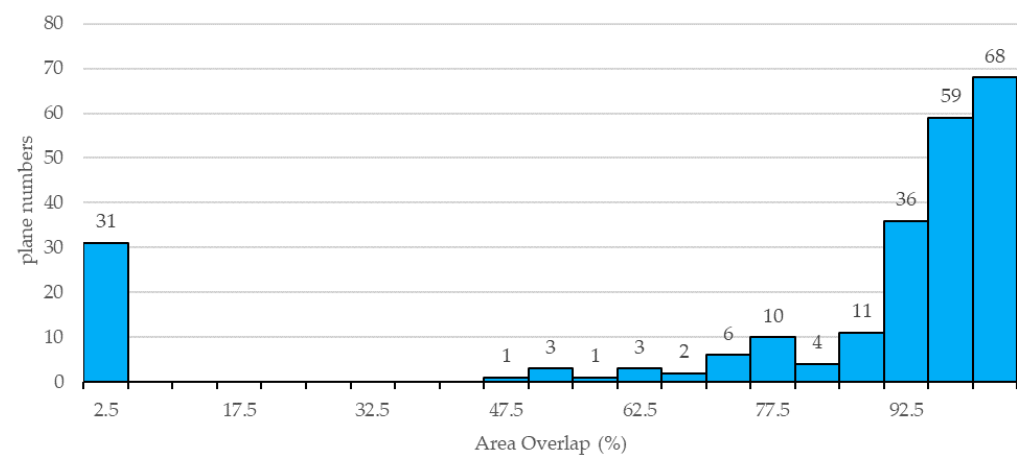
Figure 19. Plane overlap assessment—histogram of the overlap of reference roof planes by ISPRS.